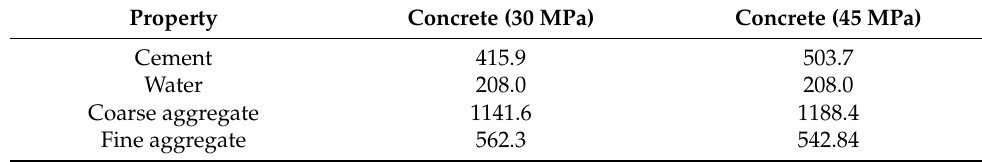
Table 2. Mix proportions of concrete (kg m − 3 ).